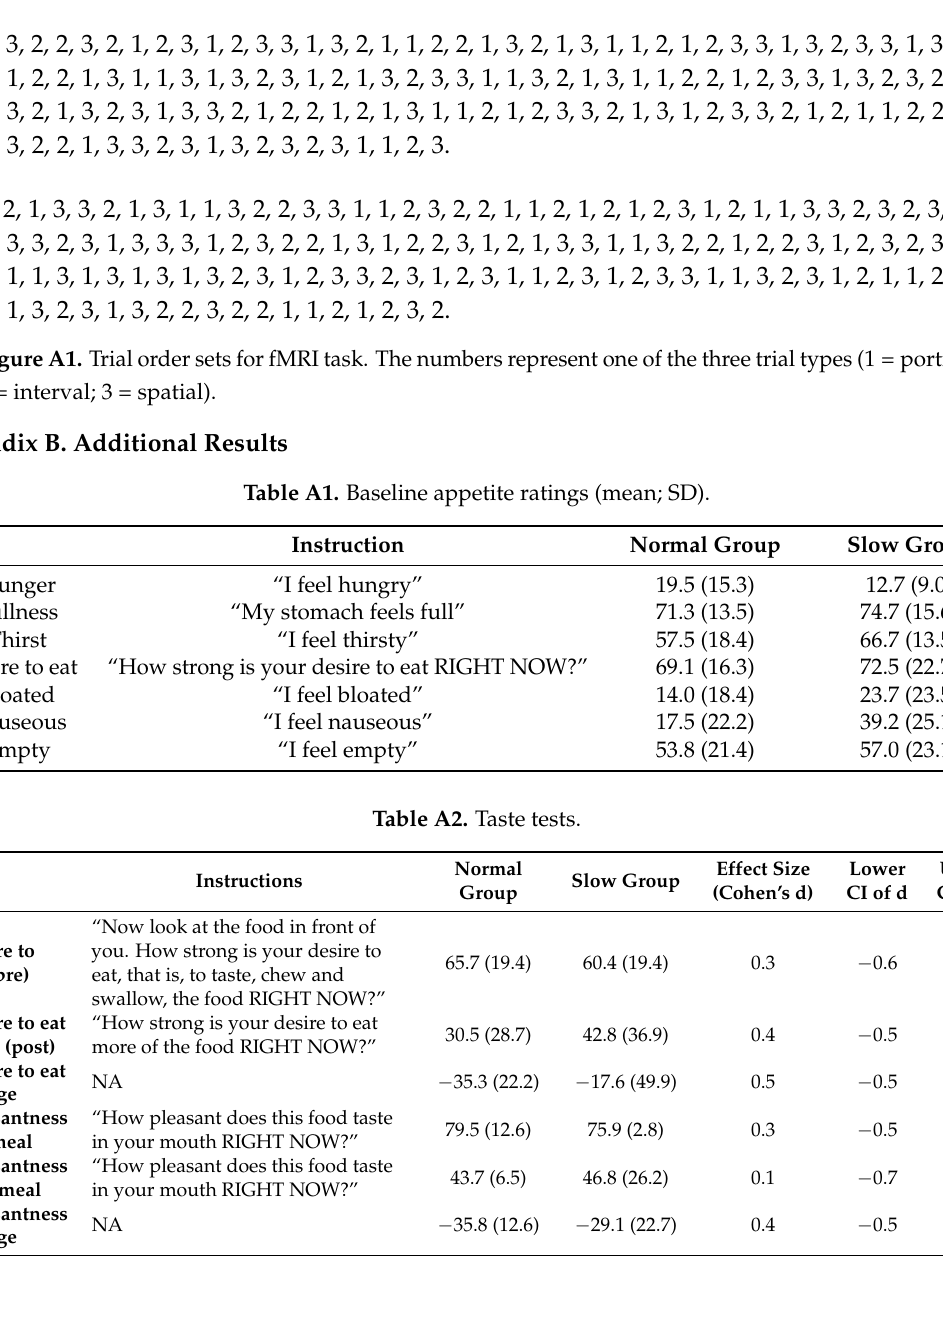
Figure A1: Trial order sets for fMRI task